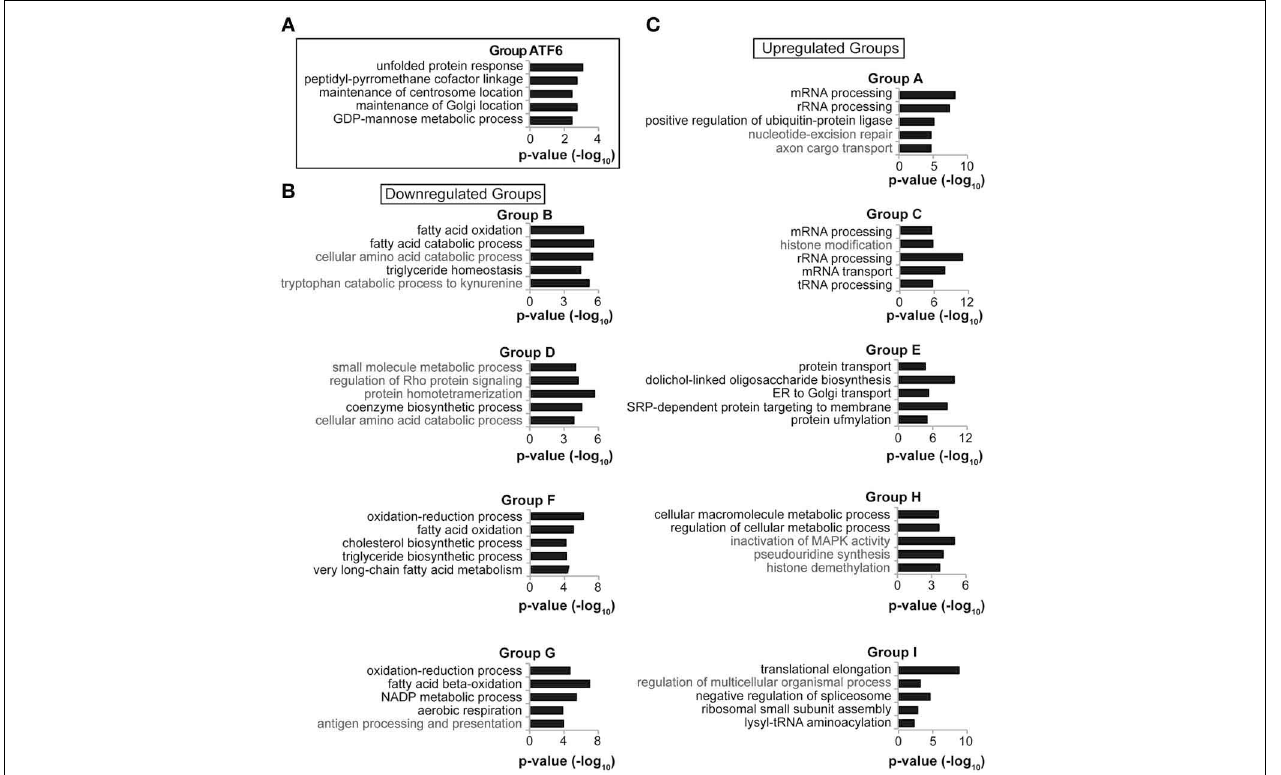
FIGURE 5 | Functionally related genes cluster by temporal regulation. (A–C) Each of the gene groups in Figure 4 was subjected to Gene Ontology pathway analysis using FunNet. The top seven most significant pathway enrichments were then reordered by the number of genes from that group that were pathway “hits,” with pathways having the most “hits” listed higher.